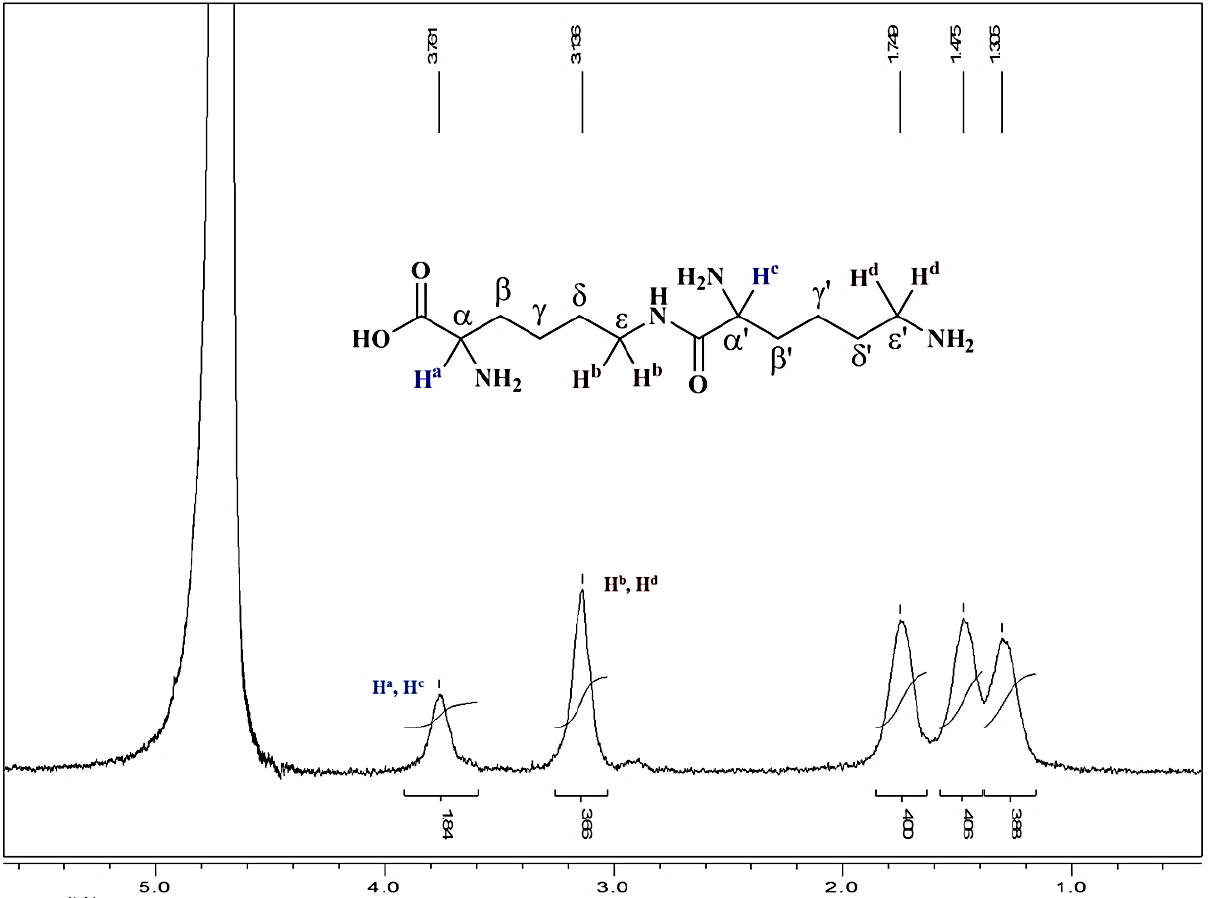
Figure 2 1 H of ε - PL (left lane) in D 2 O water. Figure 2. 1 H of ε -PL (left lane) in D